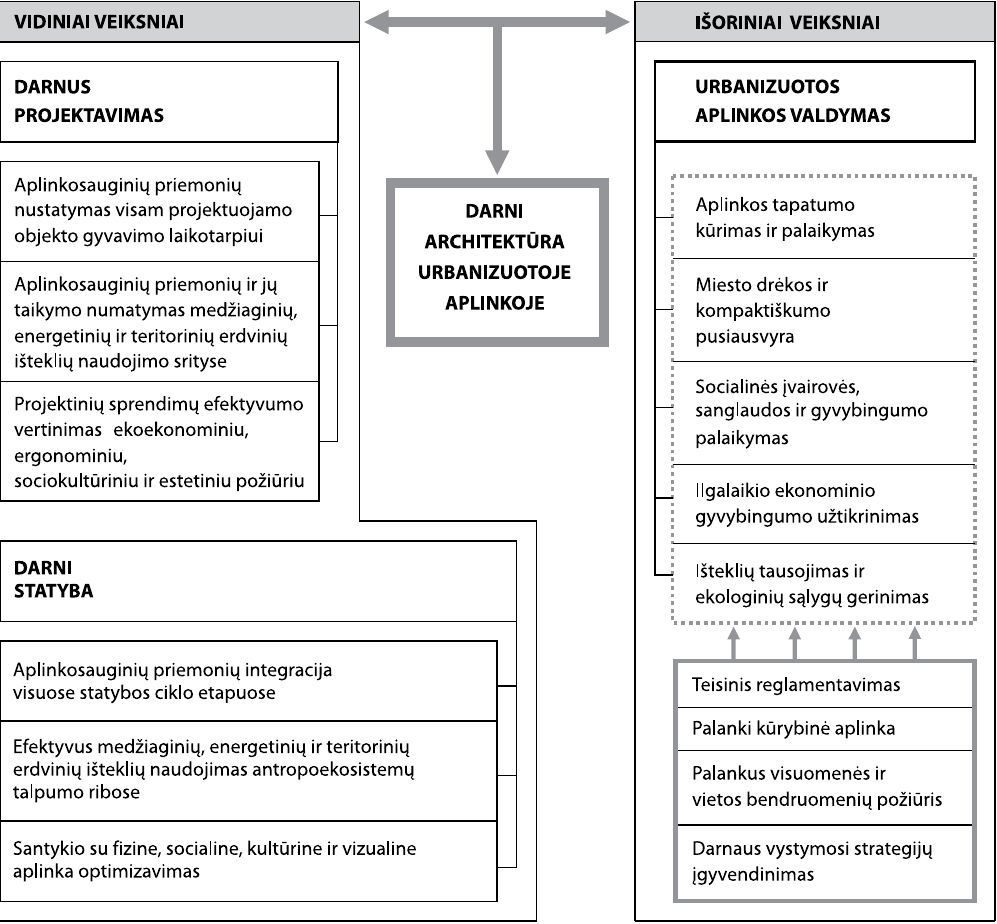
Fig. 3. hypothetical model for developing sustainable architecture in the urban